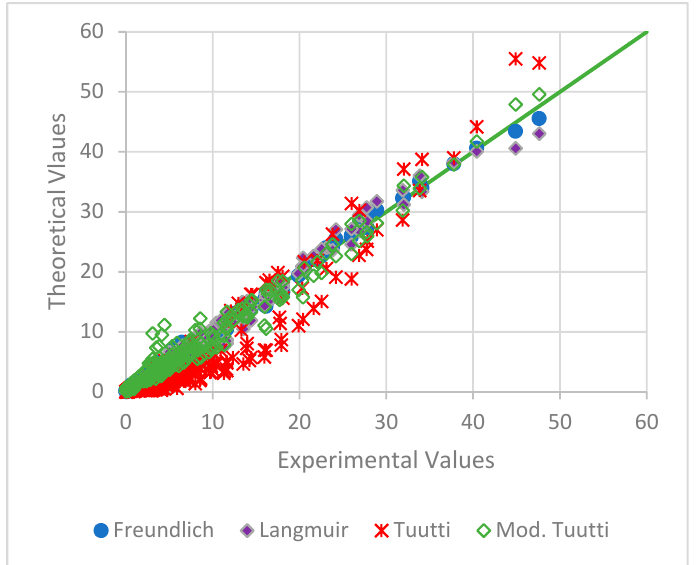
Figure 6. Linear regression analysis of the theoretical versus experimental results in the literature.